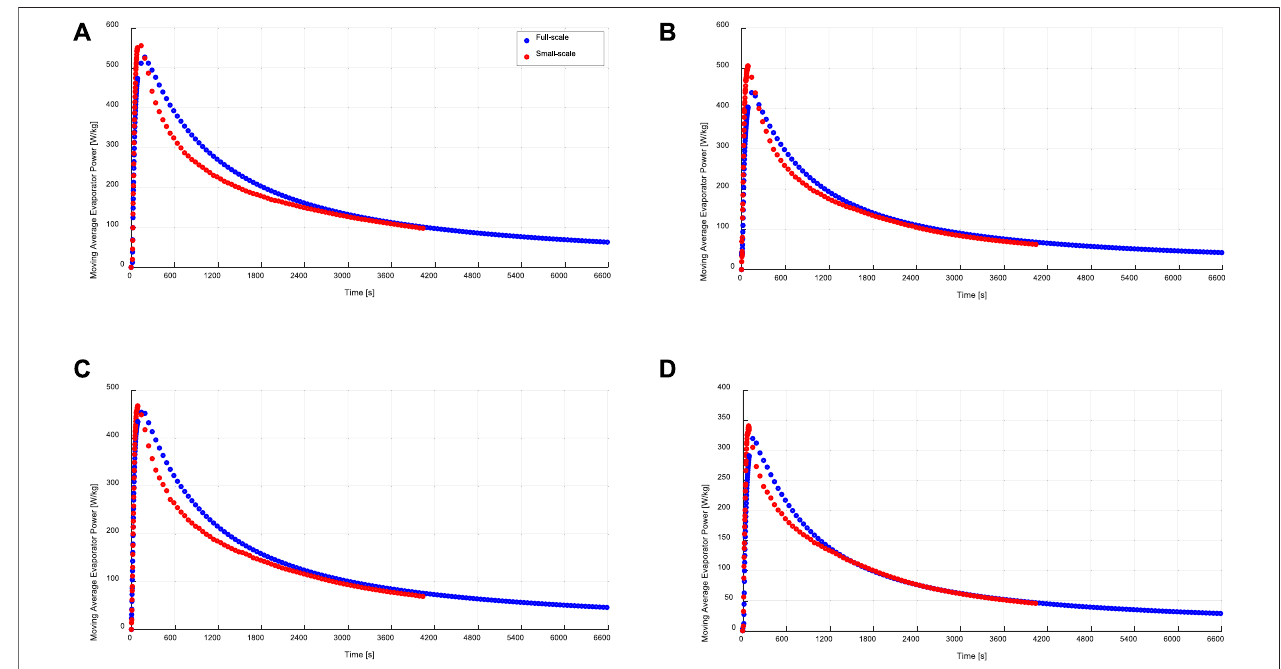
FIGURE 9 | Speci fi c moving average evaporation power of the evaporator/condenser unit (full-scale) and that estimated from the kinetic results of the adsorbent sample (small-scale), at (A) 15/30/90 ° C, (B) 15/35/90 ° C, (C) 10/30/90 ° C, (D) 10/35/90 ° C.